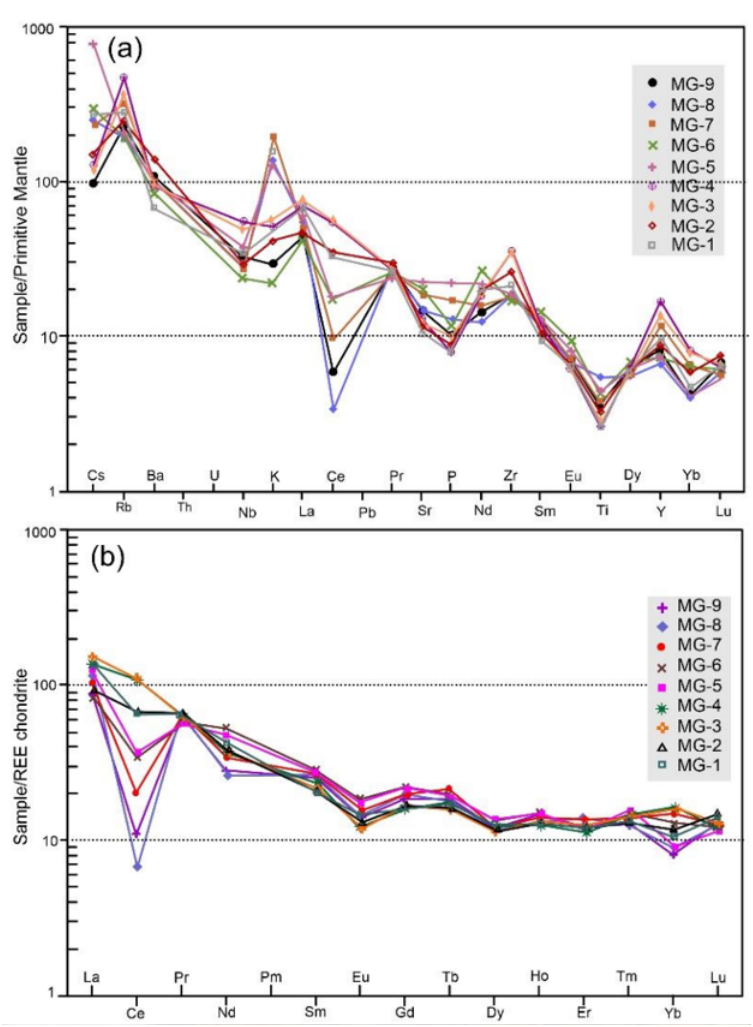
Figure 8. ( a ) Primitive mantle-normalized trace elements [52]; ( b ) chondrite-normalized rare earth elements [56] diagrams for the Shah-Ali-Beiglou